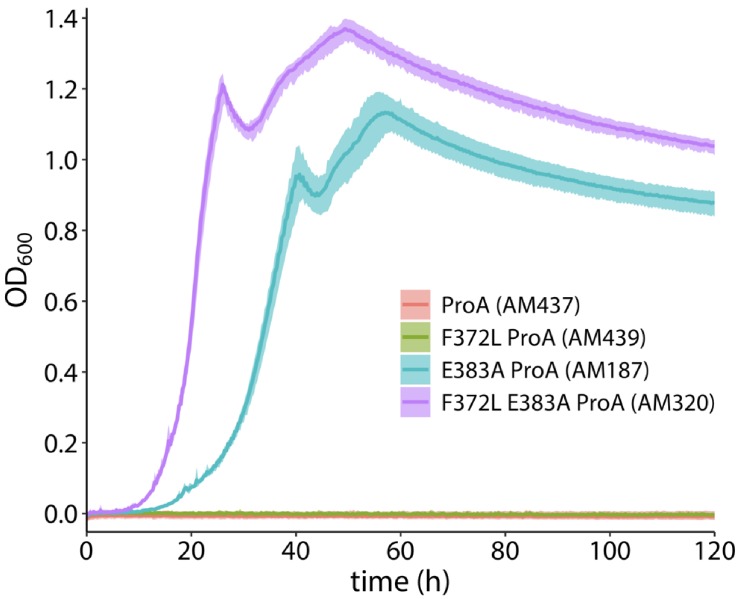
Growth of the parental strain (AM187) and comparable strains with various proA alleles in the genome.Each strain has the M2 proBA promoter mutation that was in AM187 at the start of the evolution. The solid line shows the average values of four replicate populations. The shaded area shows the minimum and maximum values of the replicates. The strains containing wild-type ProA and F372L ProA showed no detectable growth by eight days.